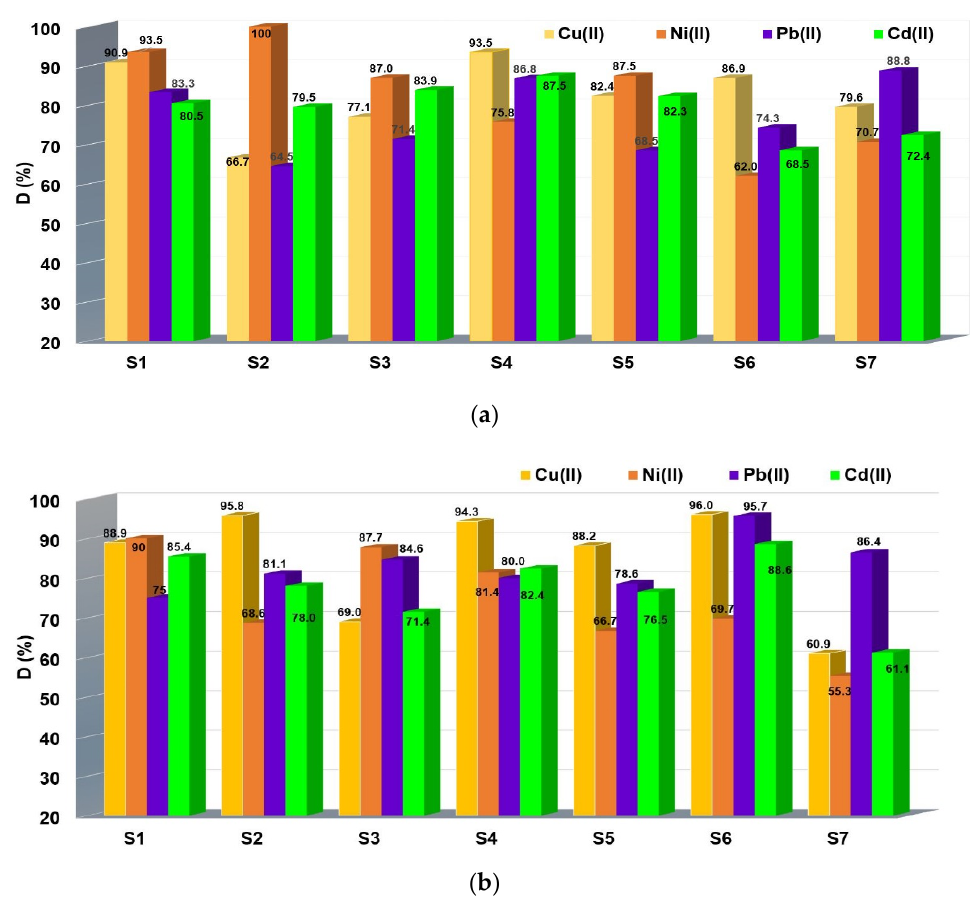
Figure 7. Effect of 2 M HCl solution on M 2+ desorption from chelating material exhausted ( a ) IRA402- DR 23-M 2+ and ( b ) XAD7HP-DR 23-M 2+ , where S1 to S7 represents the solid phases of IRA 402-DR 23-M 2+ and XAD7HP-DR 23-M 2+ obtained in Section 3.6. that were subjected to desorption studies.